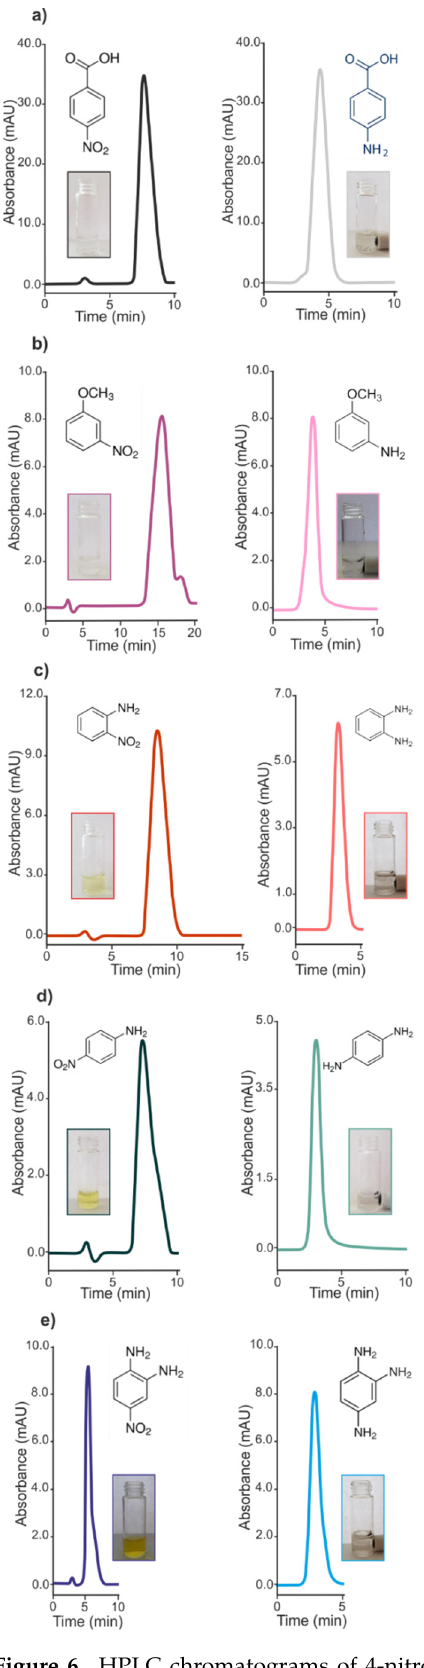
Figure 7. HPLC chromatograms of 4-nitrobenzoic acid ( a ) 3-nitroanisole ( b ), 2-nitroaniline ( c ), 4-nitroaniline ( d) , 4-nitro- Figure 6. HPLC chromatograms of 4-nitrobenzoic acid ( a ), 3-nitroanisole ( b ), 2-nitroaniline ( c ), o-phenylenediamine ( e ) and their reduction products. 4-nitroaniline ( d ), 4-nitro-o-phenylenediamine ( e ) and their reduction